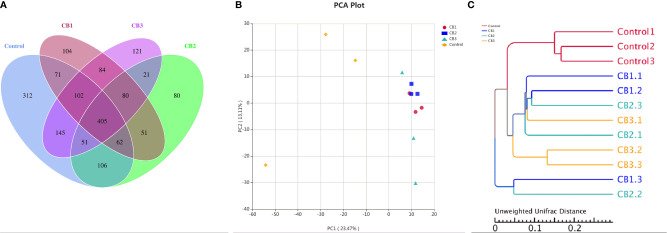
Effects of early life intervention using Clostridium butyricum on intestinal microbial structure of large yellow croaker larvae (n = 3/group). (A) Venn diagram; (B) principal component analysis (PCA); (C) unweighted uniFrac distance matrix.